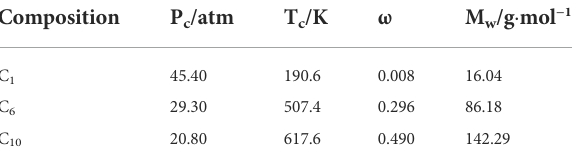
TABLE 1 Physical parameters of components for case 1.